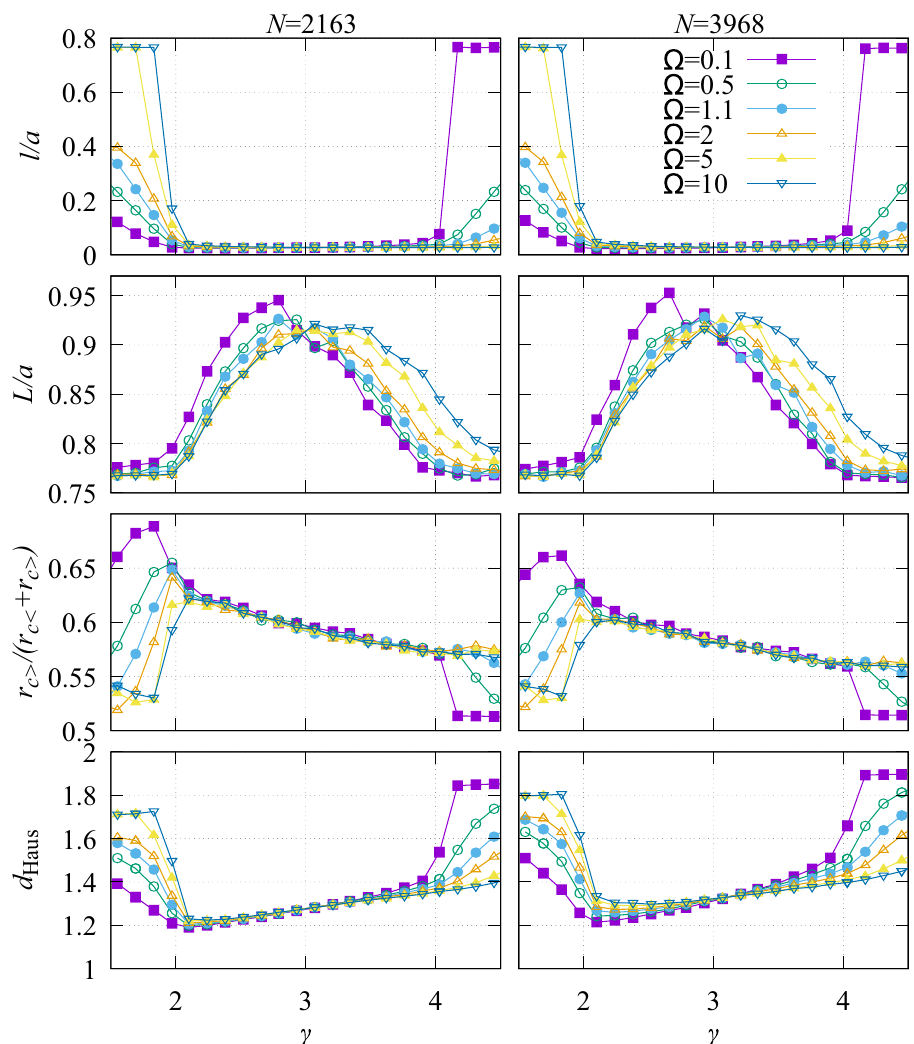
Figure 6. The tree morphology is dependent on the bifurcation exponent, but essentially independent of variation in (cid:31) within the region of physiological interest between γ dependent on (cid:31) outside this range. There is only minor dependence on tree size at any values of γ and (cid:31)